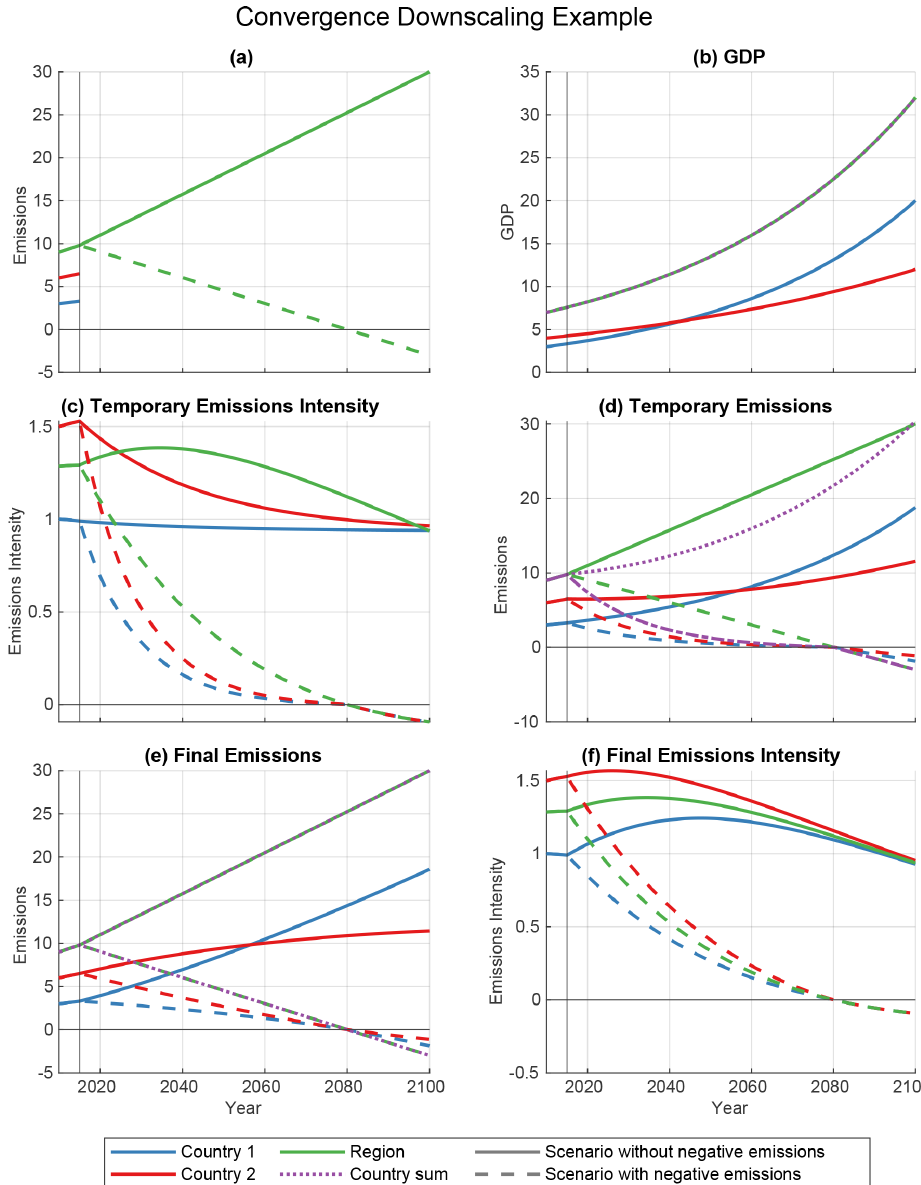
Figure 2. Steps of convergence downscaling of regional emission data using the IPAT equation and country GDP data for a two-country region for positive and negative regional emissions. Regional emission data are given for the whole time period, while for the countries only historical data are available (a) . GDP data are given for both countries and the region for the whole time period (b) . In the first step temporary emission intensity pathways for the countries are calculated using exponential convergence from historical values (2015). In the case of completely positive regional pathways, emission intensities converge to the regional value in a given convergence year (2150, c ). In the case of negative emissions, convergence to the regional emission intensity is in the last year before the transition to negative emissions. After that year regional emission intensities are used. Multiplication with the given GDP time series creates temporary emission time series (d) . These do not sum up to the regional values (see d ) and have to be scaled to the regional value (results in e ). This also changes the emission intensities (f)